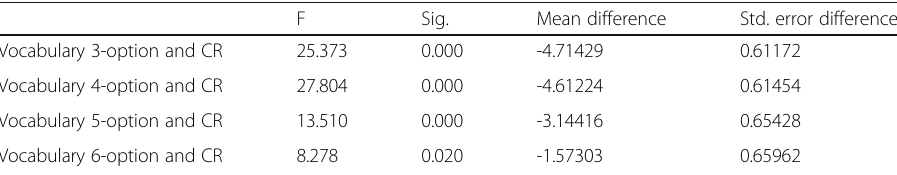
Table 4 Independent samples t test results for 3-, 4-, 5-, and 6-option MC and CR Differences F Sig. Mean difference Std. error